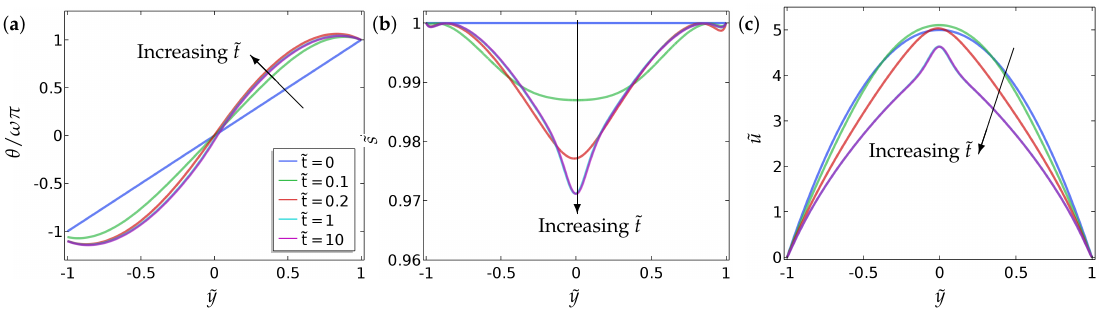
Figure 12. The dynamic evolution of ( a ) the director orientation ( θ ) , ( b ) the order parameter ( ˜ s ) and ( c ) the velocity profile ( ˜ u ) for the asymmetric case (Equation (16)). The values of the parameters used are B = 1/3, ω = 1/2, L ∗ = 10 − 3 , L 2 = 10, ˜ p x = 10 and L 1 = 10 − 6 . The profiles of θ are asymmetric − (around ˜ y = 0) because of the inhomogeneity in the θ boundary conditions (Equation (16)). The legends of all the sub-figures are the same as in ( a